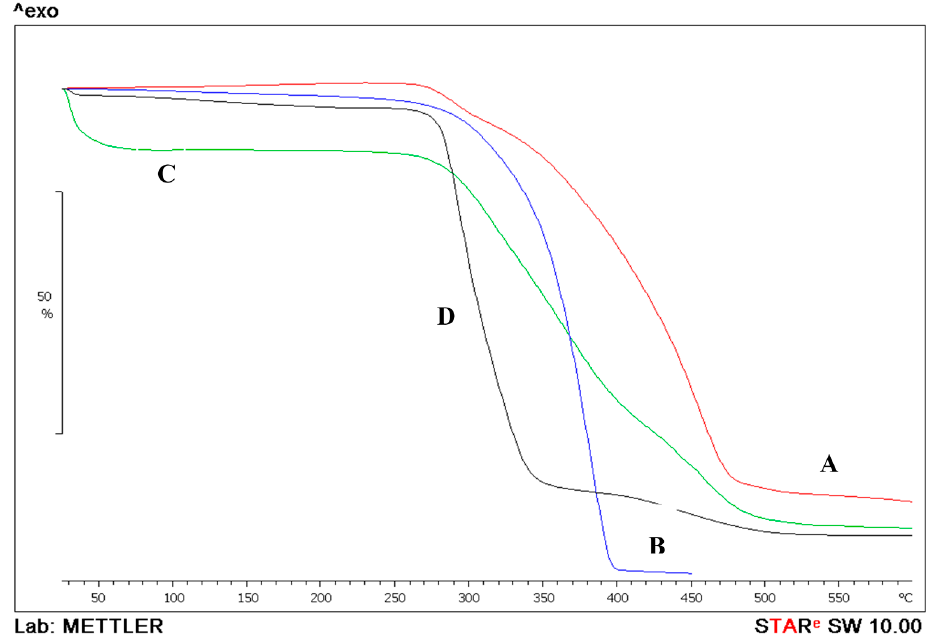
Figure 7. Thermogravimetric analysis of prednisolone ( A ), PLGA ( B ) and prednisolone-PLGA nanoparticles ( C ), PVA ( D ).